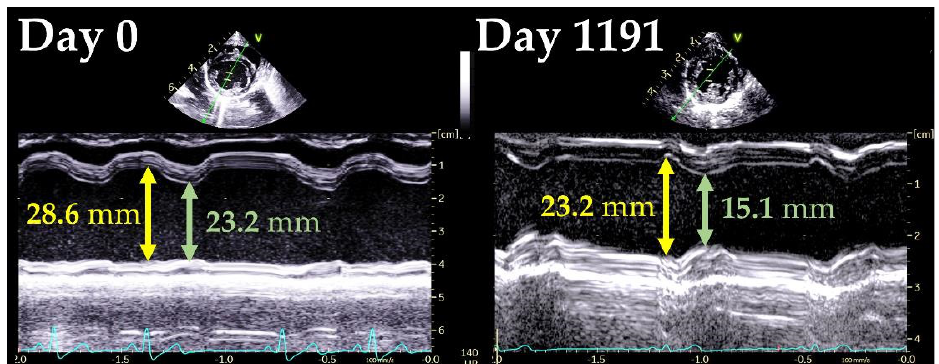
Figure 2. Changes in left ventricular internal diameter on day 0 and day 1191.